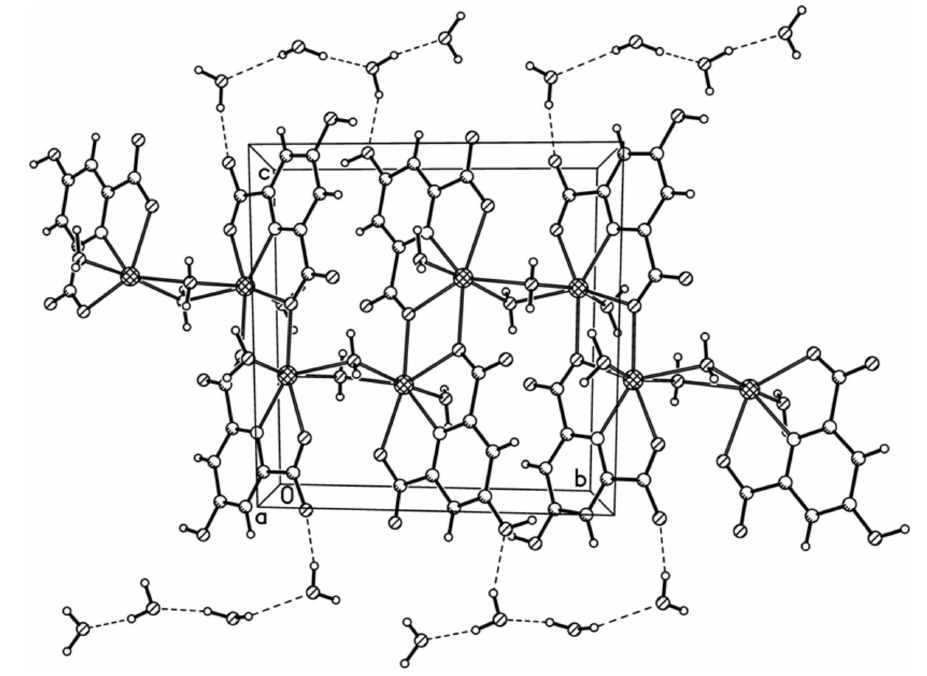
Figure 4 The crystal packing of the title compound along a crystal axis. Hydrogen bonds are shown as dashed lines.